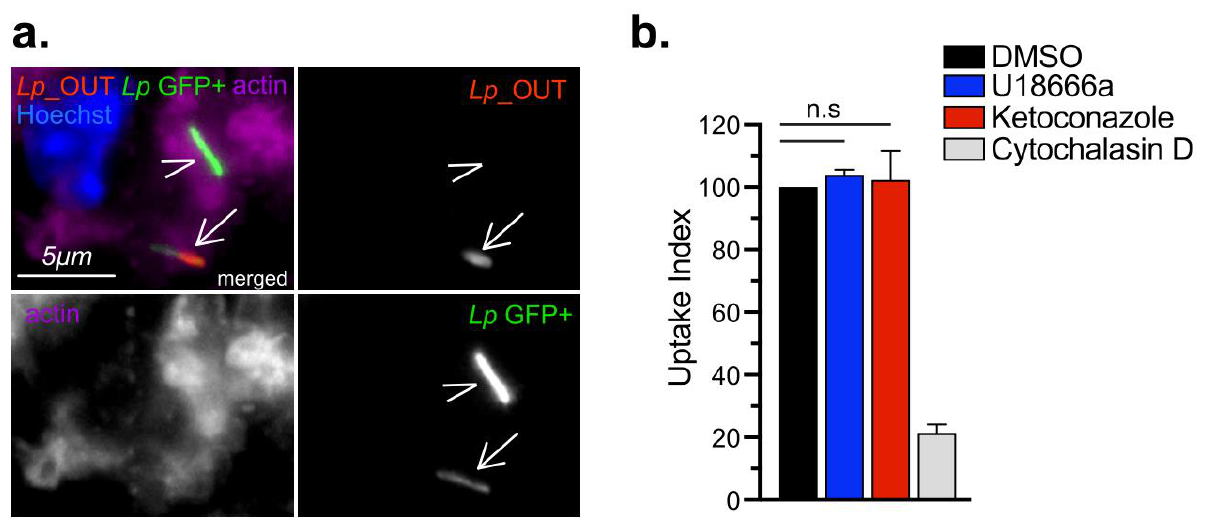
FIGURE 4: Lp uptake by U18666A- and ketoconazole-treated BMDMs. (a) Representative micrographs showing one completely (arrow head) and one partially internalized (arrow) bacterium. BMDMs were infected with GFP+ Lp ∆ flaA and stained with anti-Lp antibody prior to permeabilization to distinguish intracellular (green) from surface-associated bacteria (red and green). (b) Phagocytosis of Lp by BMDMs pre- treated for 24 hrs with either DMSO, 3.3 µM ketoconazole or 5 µM U18666A prior to a two hr infection with GFP+ Lp ∆ flaA . As a control, some BMDMs were treated with 5 µM cytochalasin D for the duration of the infection. Uptake index is calculated by normalizing the per- centage of internalized bacteria for each condition to the percentage of internalized bacteria by the DMSO-treated cells in each experiment. Bars represent average of three biological replicates ± SD where > 100 bacteria for each treatment were scored. (n.s) not-significant; one- way ANOVA. (a-b) Representative data from one of two biological replicates are